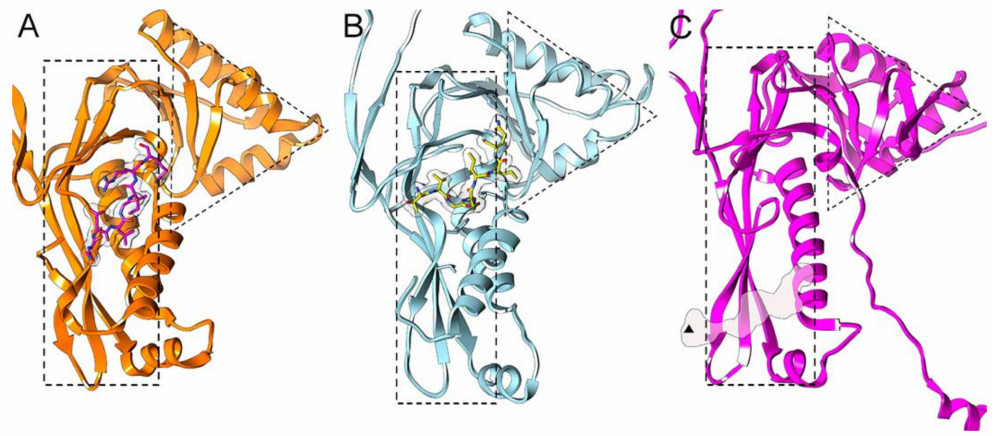
Figure 3. Binding pockets for the targeting peptide that directs protein cargo encapsulation. ( A ) The EncTm amphipathic binding pocket is located on the inner surface of the P domain. The TP of the enzyme EncFtn (GGDLGIRK) is shown (white density). TP residues are displayed as sticks (PDB entry 3dkt). ( B ) The pocket and binding of the TP of the IMEF cargo (TVFSLIQ) in the EncQt system is similar to that of EncTm (PDB entry 6nj8). ( C ) Binding of the TP of the cysteine desulfurase in the EncSe system (PDB entry 6 × 8m) is near the three-fold symmetry axis (black triangle), distant from the pockets in EncTm and EncQt. Dashed rectangles and triangles correspond to P and A domains,